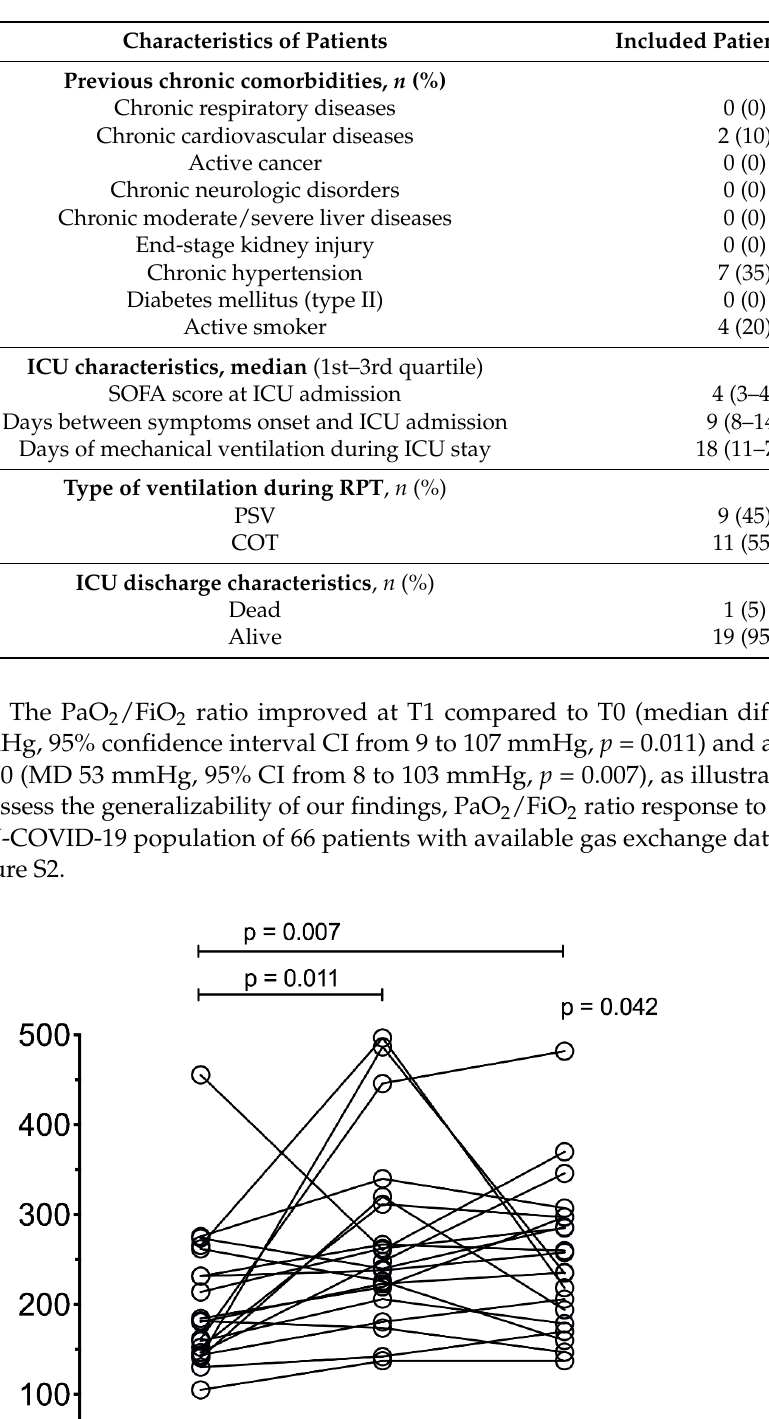
Figure 4. LUS score at baseline (T0) and after RPT (T1). In this figure all the twenty patients are represented as circles. The response of LUS to RPT is represented by a black line during the study time (from T0 to T1).